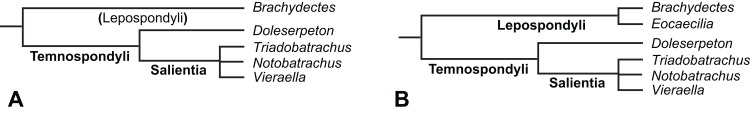
Topological constraints used in Analyses O2, O3, R2, R3, R5 and R6 (see Table 1).These are backbone constraints: the OTUs not mentioned in the constraints were free to be positioned anywhere within the constraint tree (including at its root), and the polytomies were allowed to be resolved in all mathematically possible ways. (A) Constraint against the LH, allowing both TH and PH; used in Analyses R2 and R5 (both of which found the TH). Whether Lepospondyli is extinct depends on the unconstrained positions of the caudates. With the positions of Brachydectes and Doleserpeton exchanged, this constraint instead enforces the LH and was used in Analysis O2. (B) Constraint for the PH, used in Analyses O3, R3 and R6.